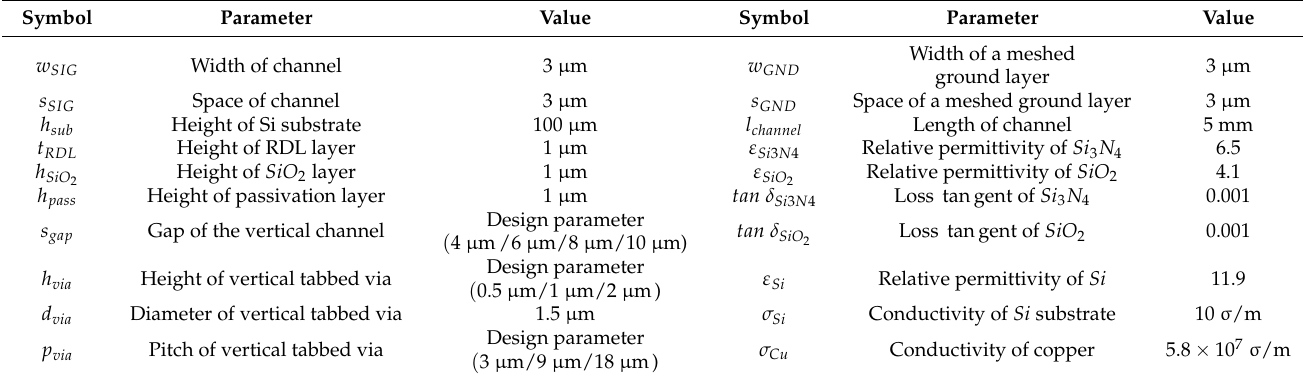
Table 1. Physical dimensions and material properties of the silicon interposer.